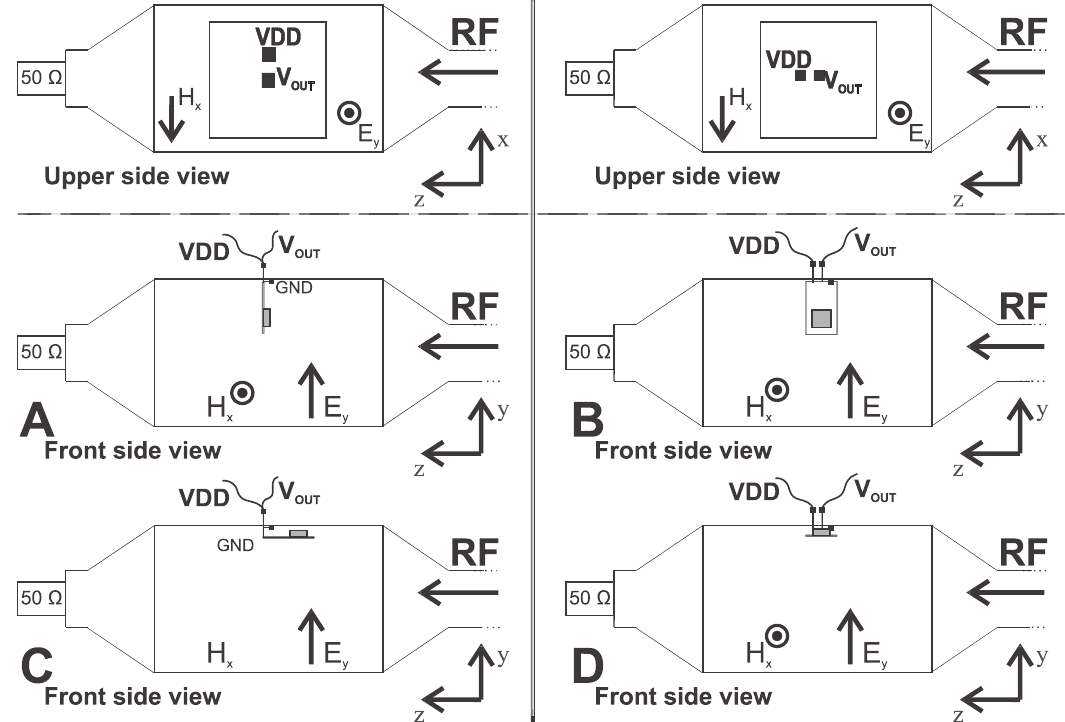
Figure 11. TEM cell testing